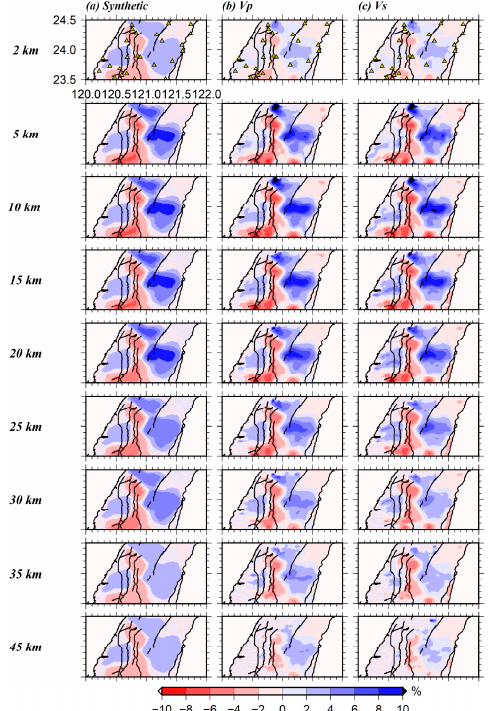
Figure 6. ( a ) A synthetic model with realistic configurations of anomalies. ( b ) Period II synthetic model of Vp. ( c ) Period II synthetic model of Vs. See the detail description in the text.